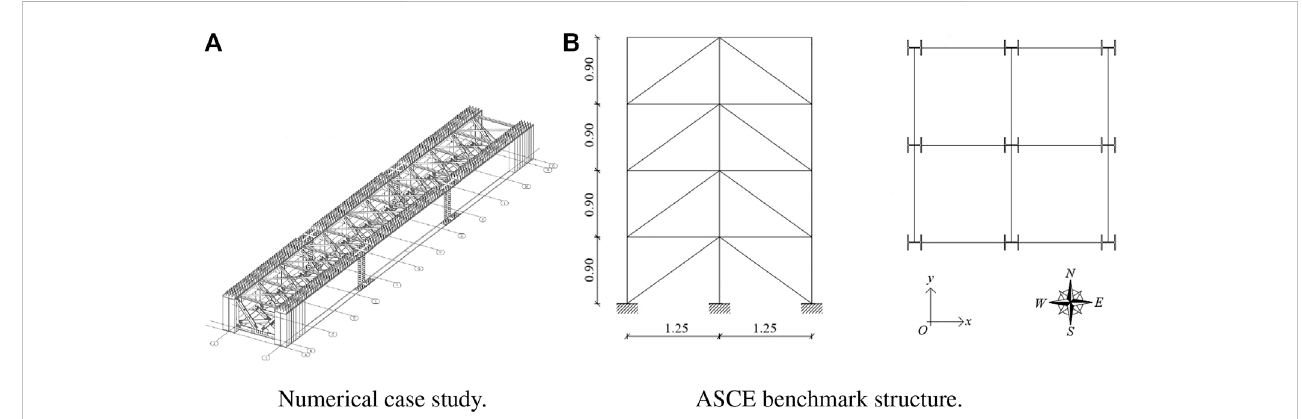
FIGURE 1 View of (A) the steel railway bridge representing the numerical case study and of (B) the ASCE benchmark steel braced frame. For the sake of clarity, the concrete slab is not shown in (A)